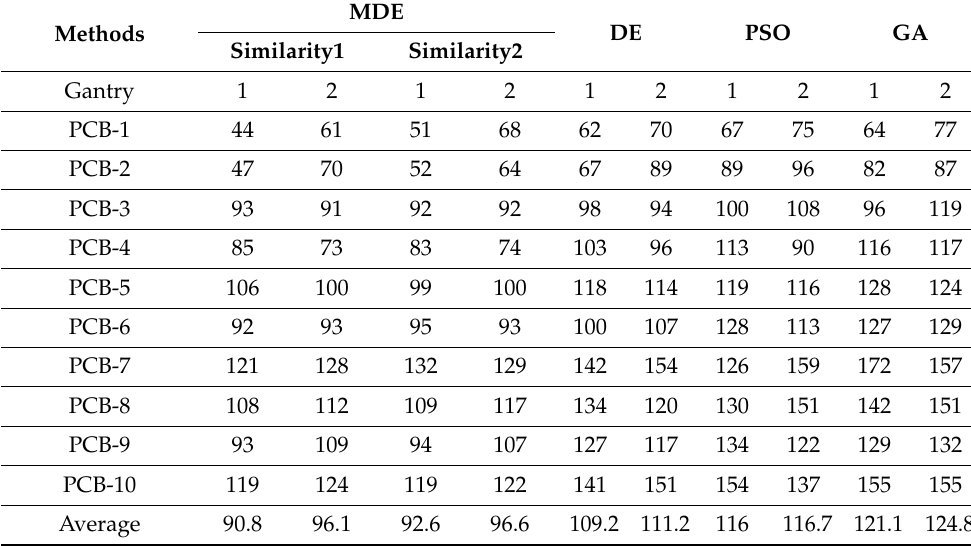
Table 4. Number of